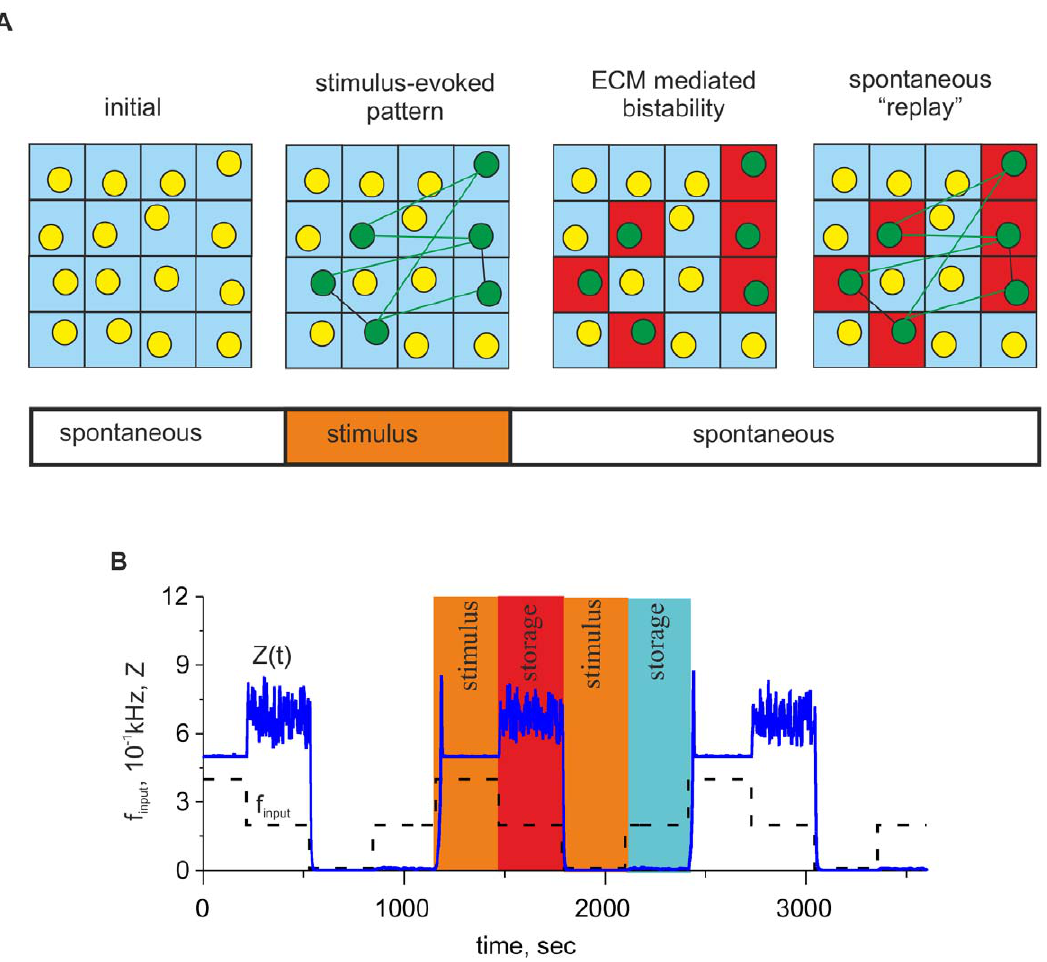
Figure 14. Potential contribution of ECM-mediated bistability to memory consolidation. A. Schematic network model illustrating how the bistability may contribute to consolidation of activity routes (from left to right). Spontaneous dynamics results in the lower level of ECM concentration. Afferent stimulation generates some activity propagation routes and, hence, increases firing rate in some cells (green circles). The ECM associated with these cells is upregulated (red squares) and may sustain their activity even after the afferent stimulus terminates. Consequently, due to higher output spiking rate these neurons may facilitate replays of the activity routes and facilitate memory consolidation. B. Response of a network neuron associated with ECM to a bipolar stimulus (dashed curve) with f in0 =0.2 kHz and f signal =0.1, 0.4 kHz . Color areas show time intervals of stimulation and spontaneous evolution at the higher (red color) and at the lower (blue color) level states. Note that there are fluctuations in Z after excitatory stimulation period, which are due to the feedback mediated by extracellular proteases. The amplitude of the spontaneous fluctuations is proportional to Z ’ ? ( Q ) . Parameter values: z 0 =p 0 =0, z 1 =p 1 =1, h z =1, k z =0.15, h p =1.5,k p =0.05, k q =0.01, a q =0.0001 msec 2 1 , b q =0.01 msec 2 1 , a z =0.001 msec 2 1 , b z =0.01 msec 2 1 , a p =0.001 msec 2 1 , b p =0.01 msec 2 1 , I 0 =4.5 m A/cm 2 , b 0 =6, c P =0.1, c ZR =0.03 and c Z =0.0 .